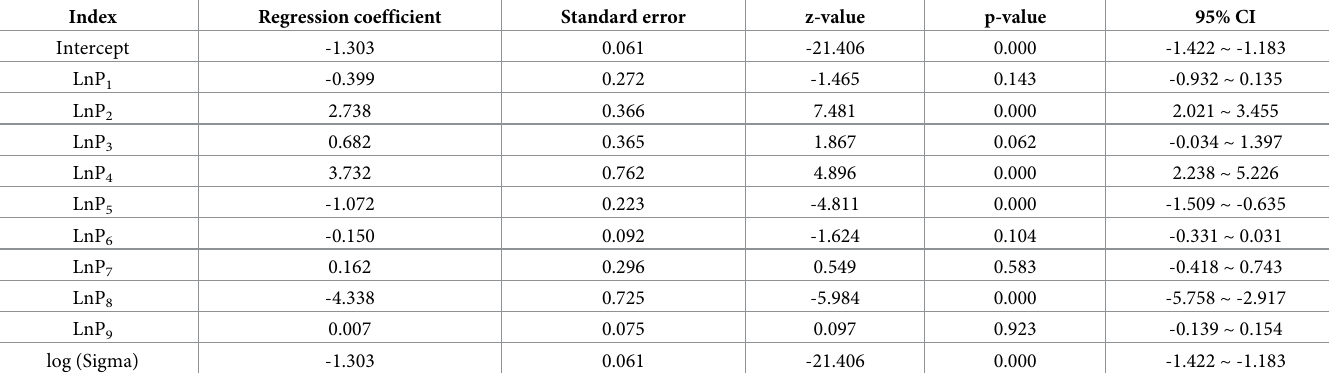
Table 7. The robustness test (the proportion of thermal power generation is replaced by per capita power